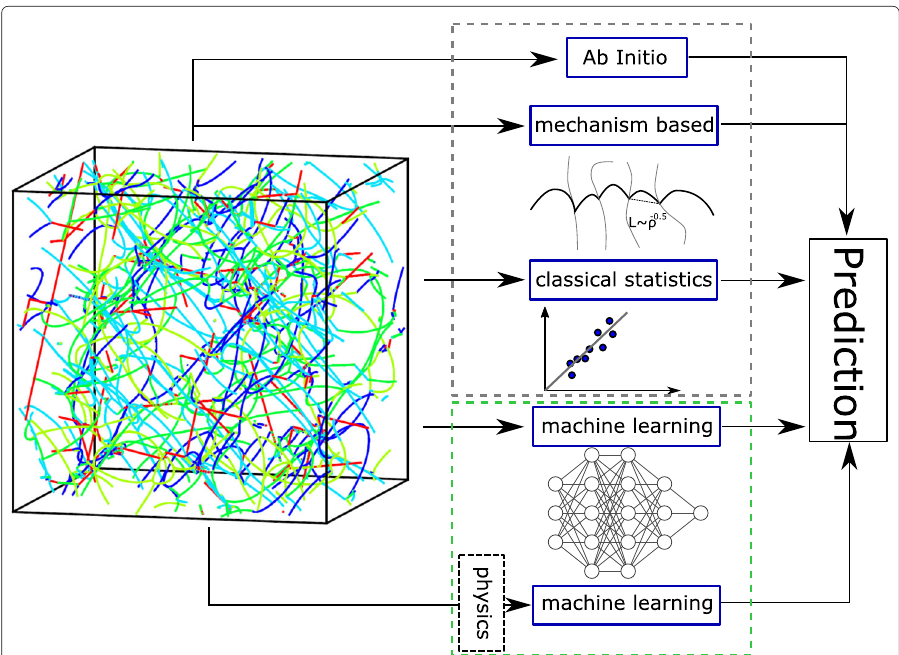
Fig. 1 Traditional (grey) and modern (green) approaches with an example DDD image from Fan et al.